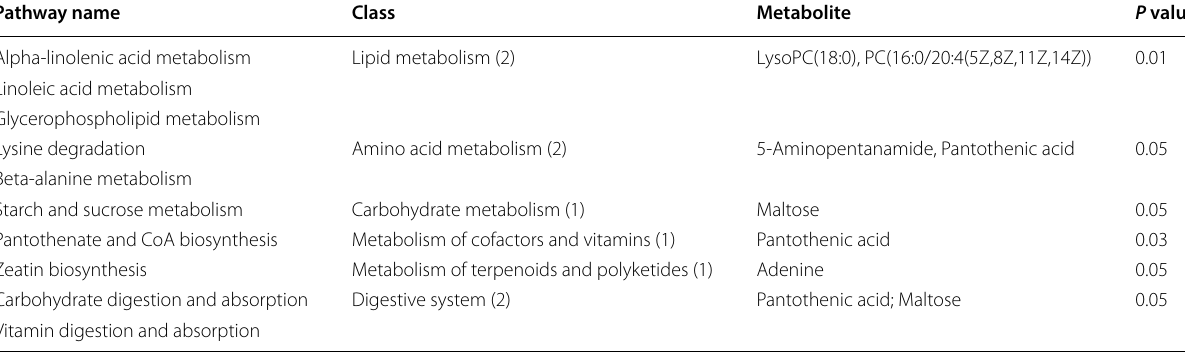
In the class column, the number in () is the number of metabolites in that class